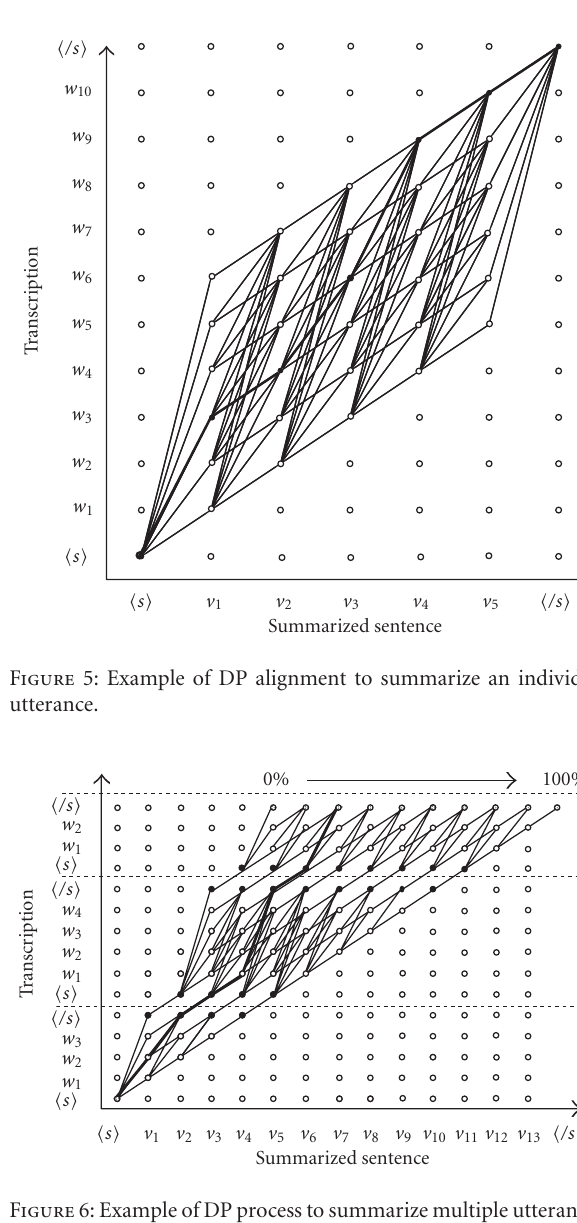
Figure 6: Example of DP process to summarize multiple utterances.